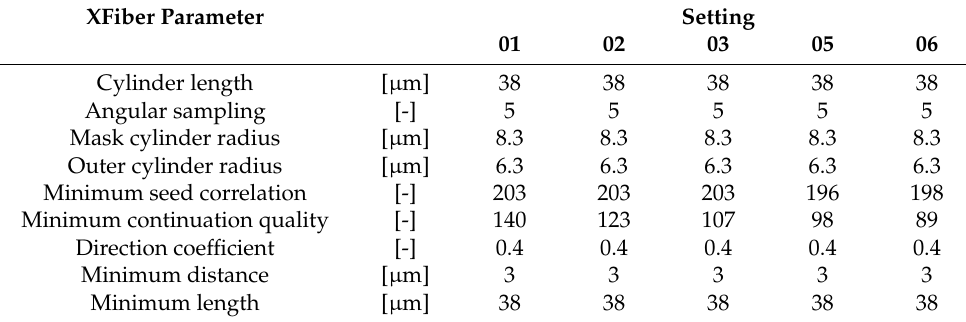
Table 5. XFiber extension settings for the individual evaluated